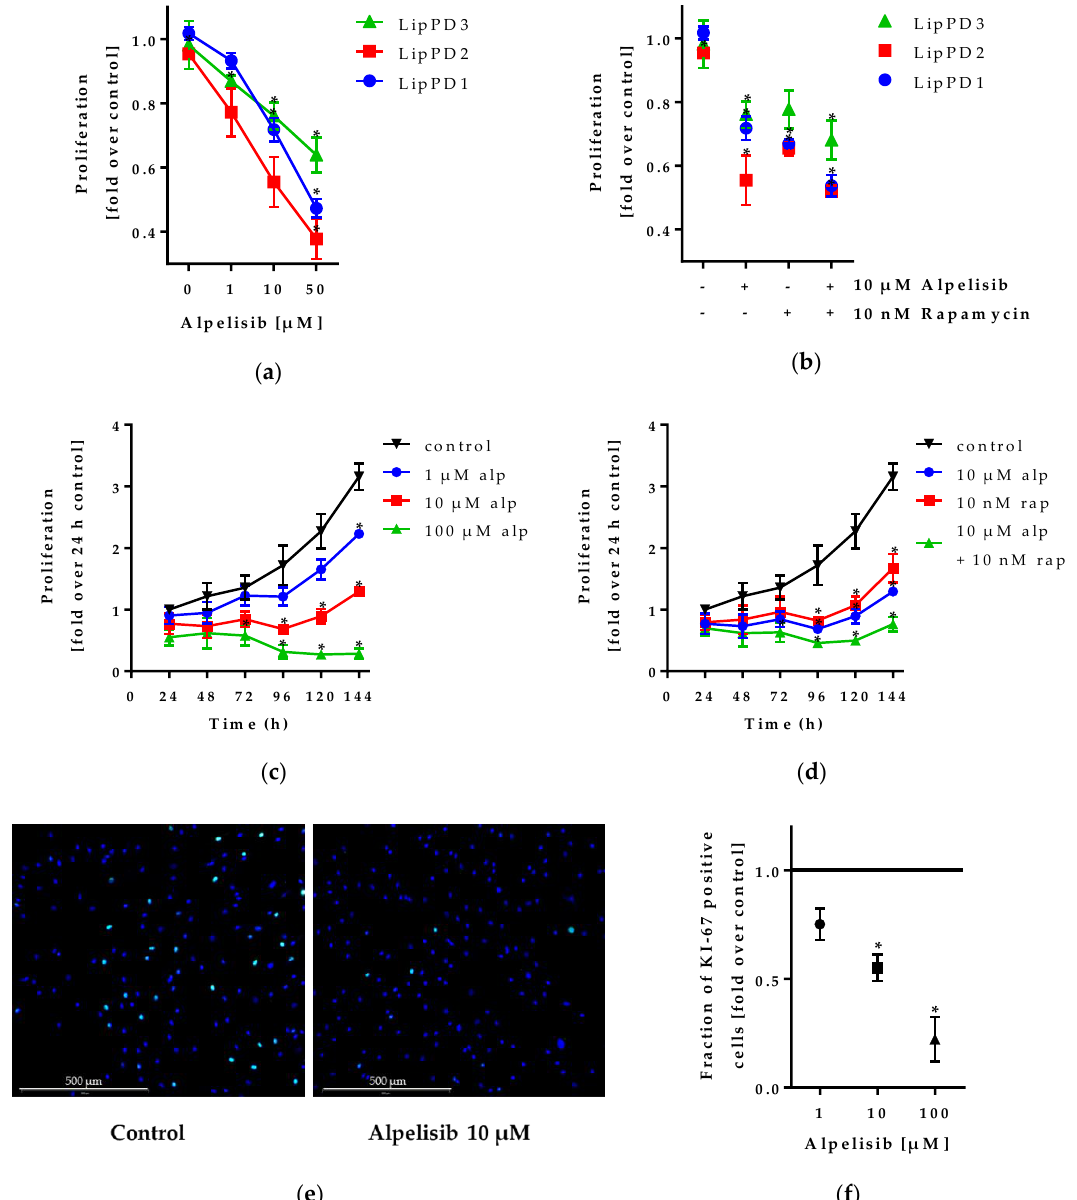
Figure 2. Hoechst proliferation assay and Ki-67 proliferation marker immunofluorescence staining after alpelisib/alpelisib+rapamycin treatment in PTEN-haploinsufficient lipoma cell cultures: ( a ) 72 h alpelisib treatment attenuated proliferation in a concentration-dependent manner in three different lipoma cell cultures; ( b ) a combined treatment with alpelisib and rapamycin further decreased cell count. Fold over solvent control, n = 3, * p ≤ 0.05. ( c ) Cell counts in LipPD1 cells during six days of 100 µM alpelisib (alp) treatment did not increase, while cells in solvent control proliferated; ( d ) a combination of rapamycin (rap) and alpelisib further decreased proliferation compared to treatment with alpelisib or rapamycin alone. n ≥ 3, * p ≤ 0.05 compared to solvent control. ( e ) Ki-67 proliferation marker immunofluorescence staining of LipPD1 cells after 48 h of alpelisib treatment: Merged image of nuclei (blue) and Ki-67 (green) for untreated and 10 µM alpelisib treated cells; ( f ) fraction of Ki-67 positive cells is decreased after alpelisib treatment, fold over solvent control (black line), n = 3, * p ≤ 0.05.